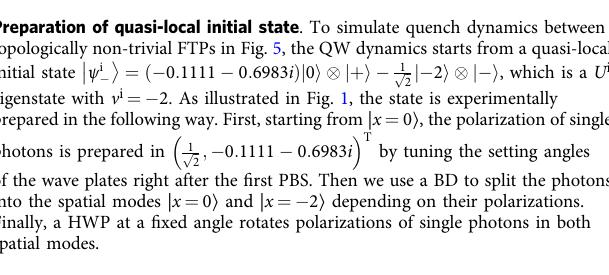
dynamic topological order parameters and dynamic Chern numbers originate from completely different topological con- structions, both are hinged upon the presence of fi xed points in quench dynamics 14,19 . With the highly fl exible control of photonic QW protocols, it would be interesting to investigate dynamic topological phenomena in higher dimensions or asso- ciated with other topological classi fi cations in the future 44 . Our work thus paves the way for a systematic experimental study of dynamic topological phenomena in both unitary and non-unitary dynamics. Methods Experimental implementation of U . We implement the coin operator